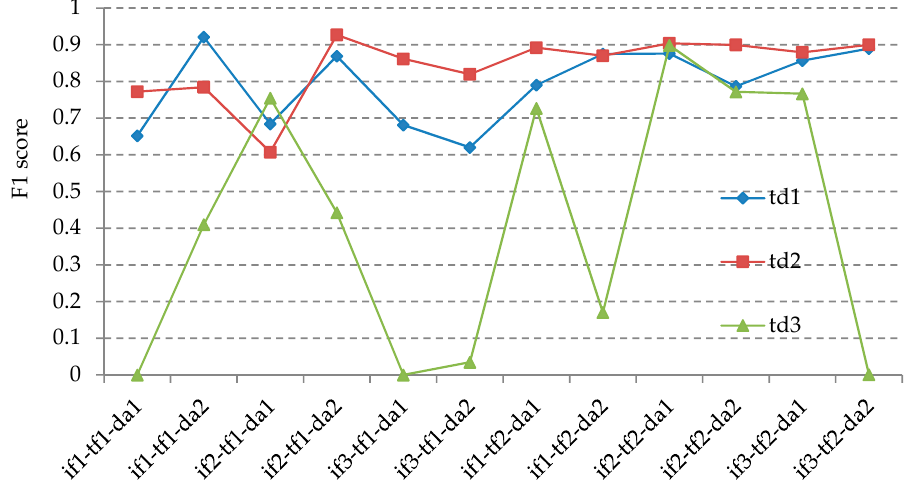
Figure 12. Average F1 scores of 10 test areas for 12 groups of models with di ff erent training data as explained in Table